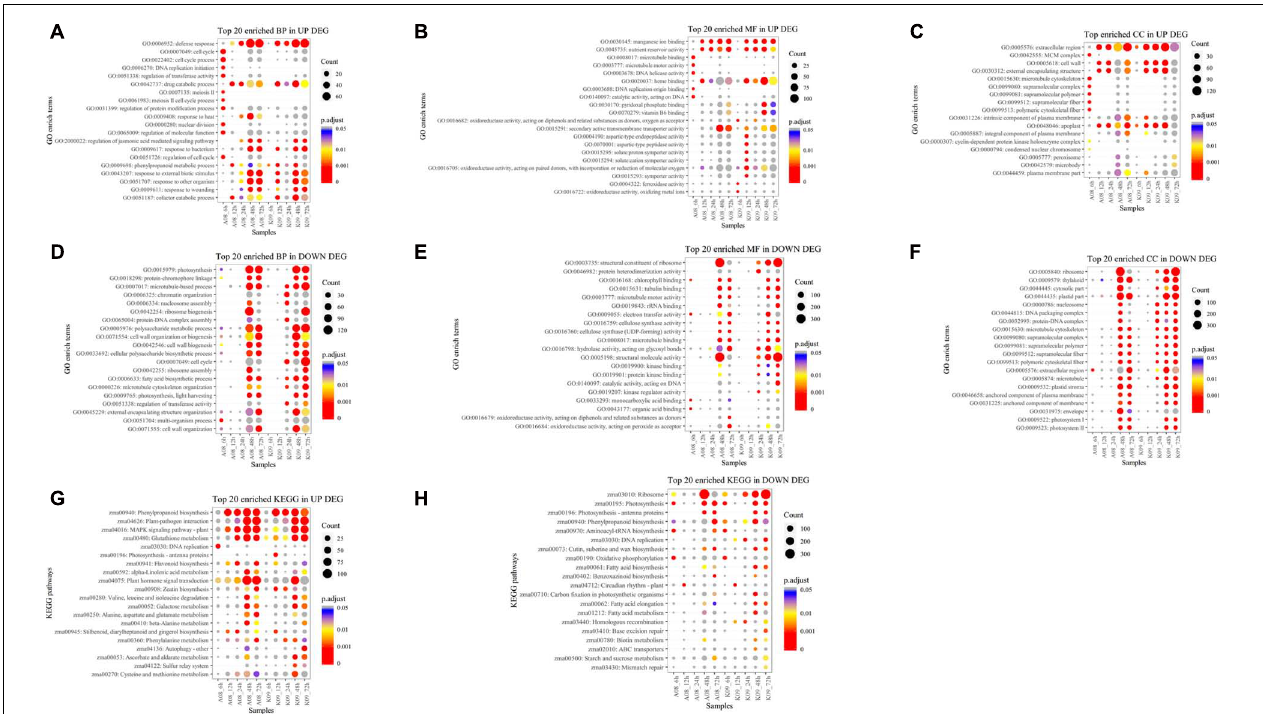
FIGURE 3 | GO term enrichment (A–F) and KEGG analysis (G,H) of DEGs identified by RNA-seq. (A) Top 20 GO terms in up-regulated DEGs significantly enriched in biological process (BP). (B) Top 20 GO terms in up-regulated DEGs significantly enriched in molecular function (MF). (C) Top GO terms in up-regulated DEGs significantly enriched in cellular compartment (CC). (D) Top 20 GO terms in down-regulated DEGs significantly enriched in BP. (E) Top 20 GO terms in down-regulated DEGs significantly enriched in MF. (F) Top GO terms in down-regulated DEGs significantly enriched in CC. (G) Top 20 significantly enriched KEGG pathways in up-regulated DEGs. (H) Top 20 significantly enriched KEGG pathways in down-regulated DEGs. The size of black dot indicates the number of gene counts. The DEGs were selected with a criterion at adjusted p -value ( p.adj ) < 0.05 shown in colored side bar.